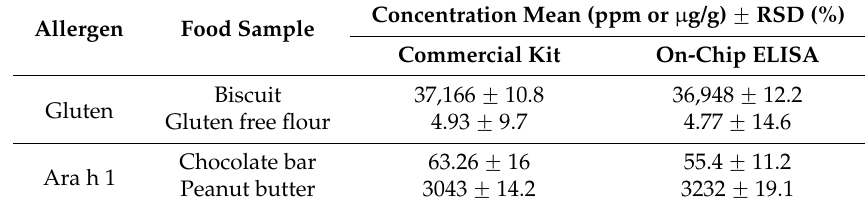
Table 1. Comparison of gluten/Ara h 1 detection of food samples by commercial kits and the developed microfluidic ELISA biosensor.